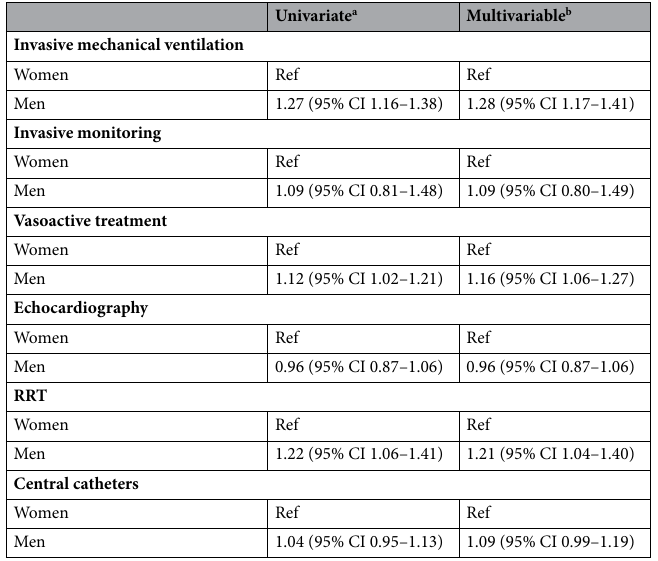
Table 2. Univariate and multivariable logistic regression analyses on all patients, exploring differences in the use of invasive mechanical ventilation, invasive monitoring, vasoactive treatment, echocardiography, RRT and placement of central catheters, based on the sex of the patient. Data presented as odds ratio and 95% CI. a 9067 and 8863 patients are included in univariate analyses and multivariable analysis respectively. b Adjusted for Age, Estimated mortality risk and Charlson Co-morbidity index. RRT Renal replacement therapy.